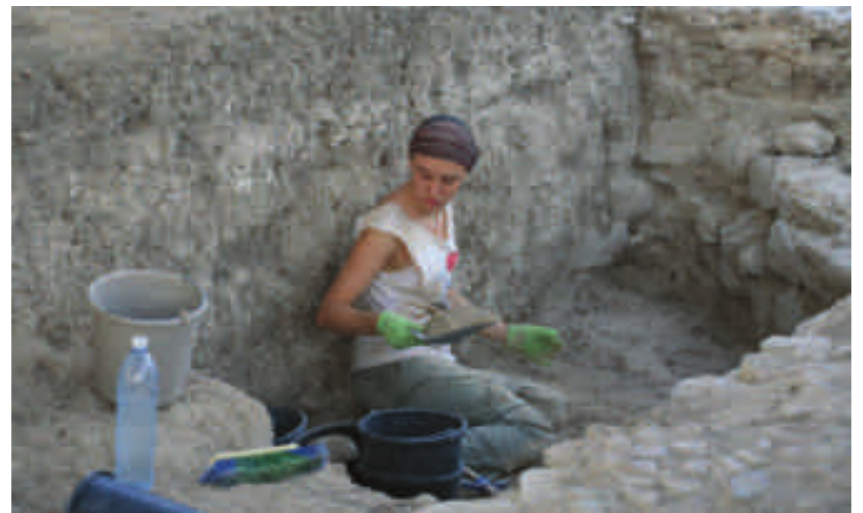
Figure 7 UCL undergraduate Leah Acheson Roberts, excavating the foundations of a Late Byzantine/ Early Islamic